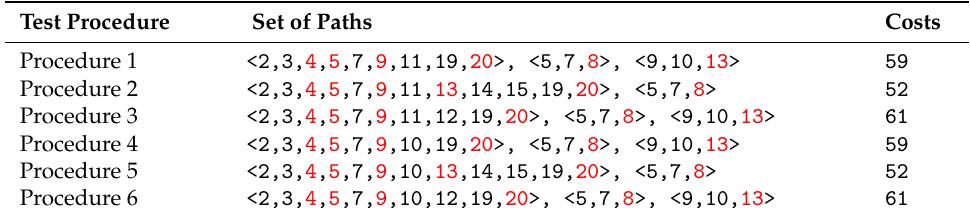
Table 5. Generated procedures and